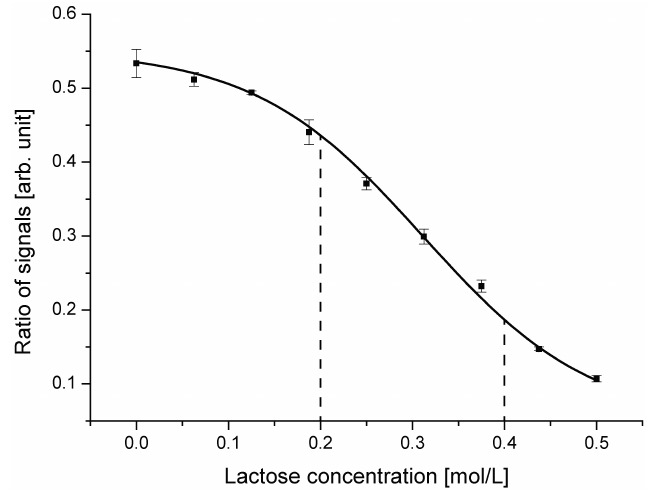
Figure 5. Ratio of reflected to transmitted light signal for the device with an incident angle of 72.5 ◦ . Highest sensitivity is obtained between 0.2 mol/L and 0.4 mol/L and defines the optimal working